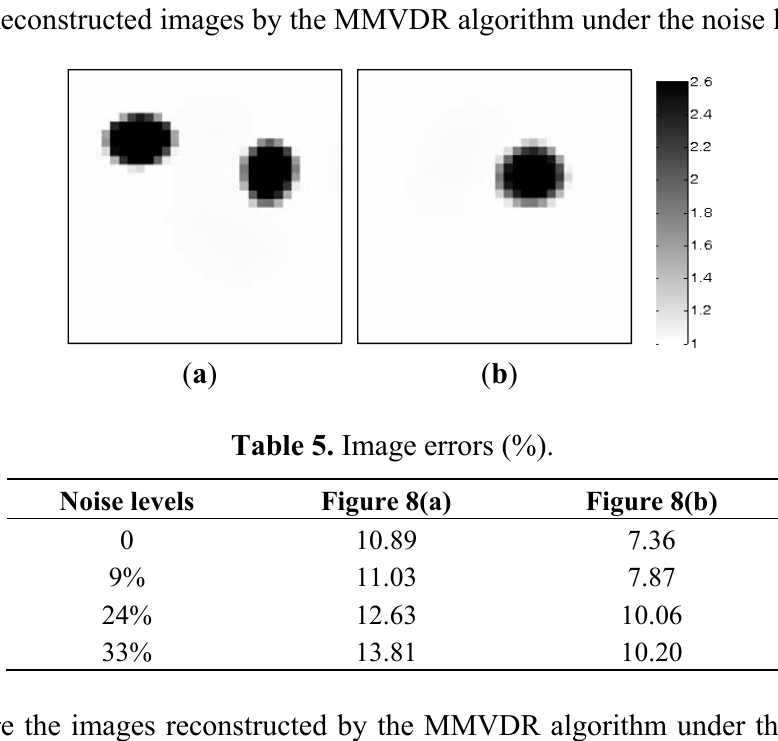
Figure 12. Reconstructed images by the MMVDR algorithm under the noise level of 33%.